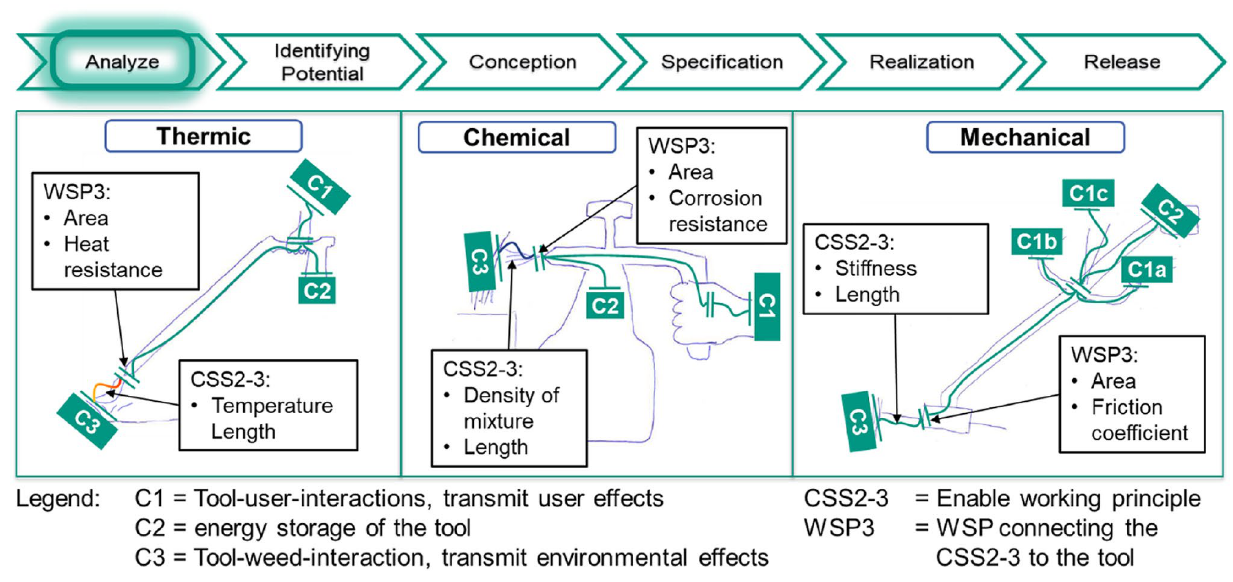
Fig. 7 Examples of working principles of competitor products based on simple